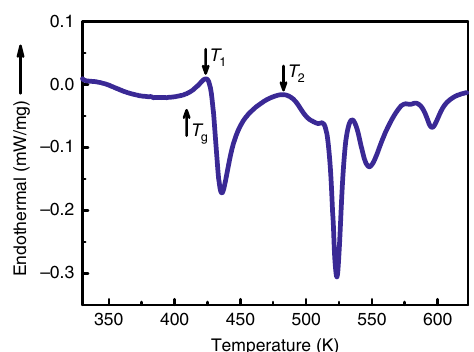
Fig. 1 The DSC curve of the as-prepared Ce 65 Al 10 Co 25 MG from 330 K to 625 K with a heating rate of 10 K per minute. The sample undergoes relaxation below the glass transition temperature, T g ~ 410 K. The fi rst exothermic peak starts at T 1 ~ 428 K and is followed by three complex reactions starting at T 2 ~ 483